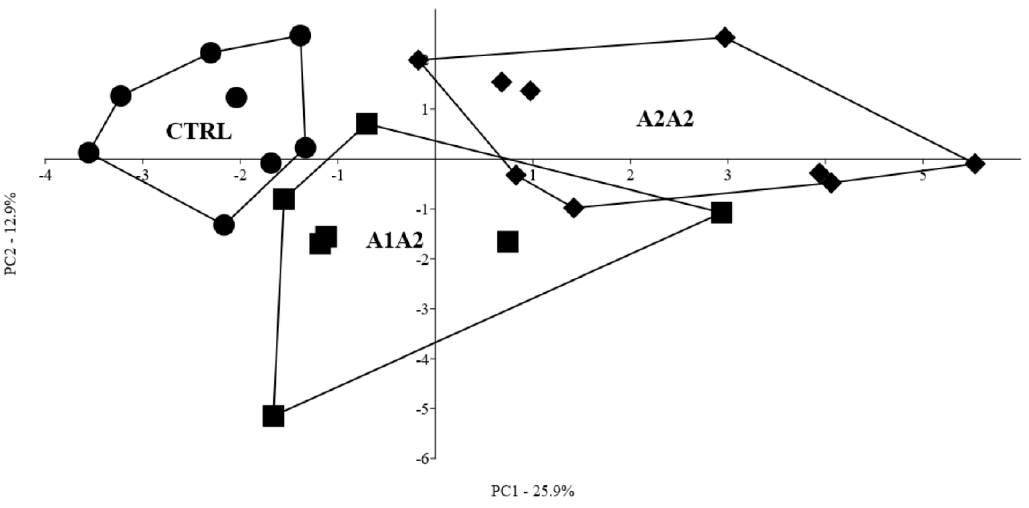
Figure 2. Principal component analysis (PCA) of intestinal immunological and morphological parameters, and faecal SCFAs measured on mice fed differently supplemented diets. CTRL, control diet ( ● ); A1A2, milk-based diet with A1/A2 beta-casein variant ( ■ ); A2A2, milk-based diet with A2/A2 beta-casein variant ( ♦ ); PC, principal component. 8 CTRL, 7 A1A2 and 9 A2A2 mice were analysed.